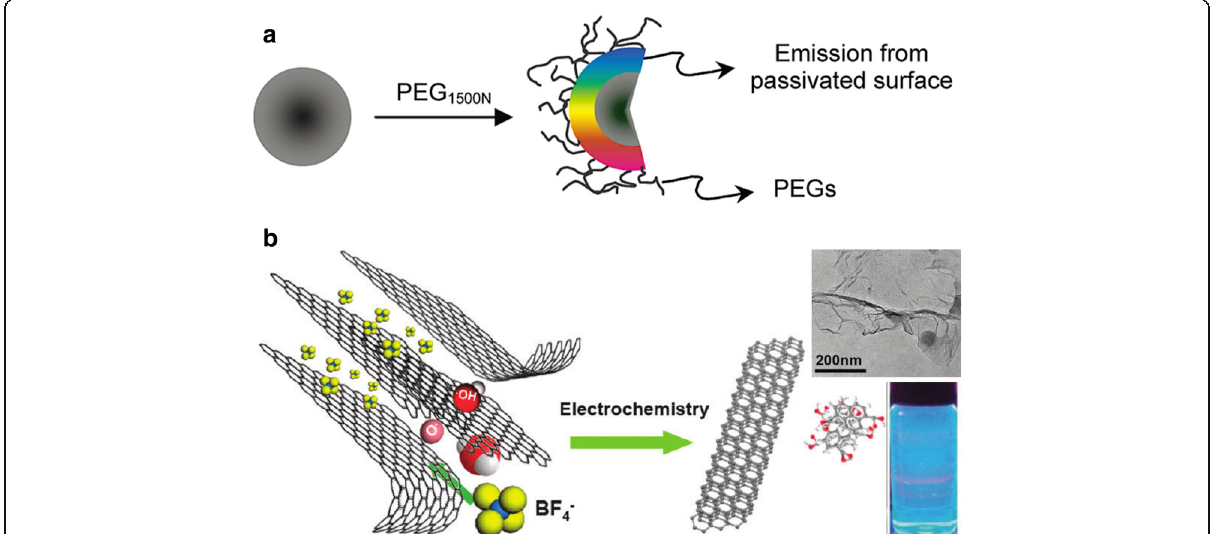
Fig. 2 Illustration of the formation of a fluorescent CDs via laser ablation with PEG attached to the surface [32] and b GCDs prepared by exfoliation in an ionic liquid [36]. The inset is a transmission electron microscopy (TEM) image of the fabricated GCDs and the solution illuminated by an UV lamp